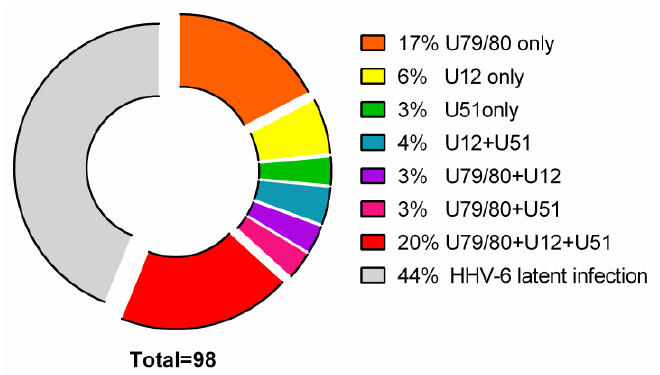
Figure 1. Distribution of HHV-6 U79 / 80 (encoding proteins involved in viral replication), U12 and U51 mRNAs (late and early genes, respectively, encoding viral homologs of cellular G-protein-coupled receptors) in AIT patients’ thyroid gland tissue samples. Results from nPCR investigations of viral gene expression using cDNA as a template.